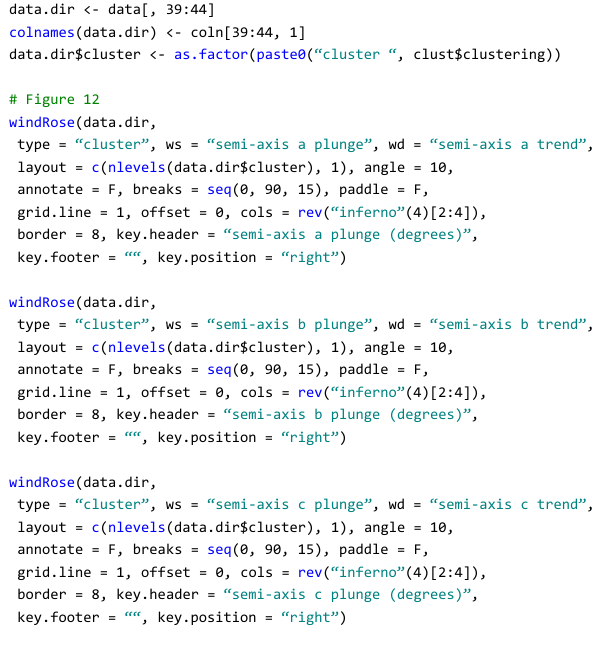
# Figure 12 # Figure 12 windRose(data.dir, windRose(data.dir, type = “cluster”, ws = “semi-axis a plunge”, wd = “semi-axis a trend”, layout = c(nlevels(data.dir$cluster), 1), angle = 10, annotate = F, breaks = seq(0, 90, 15), paddle = F, grid.line = 1, offset = 0, cols = rev(“inferno”(4)[2:4]),